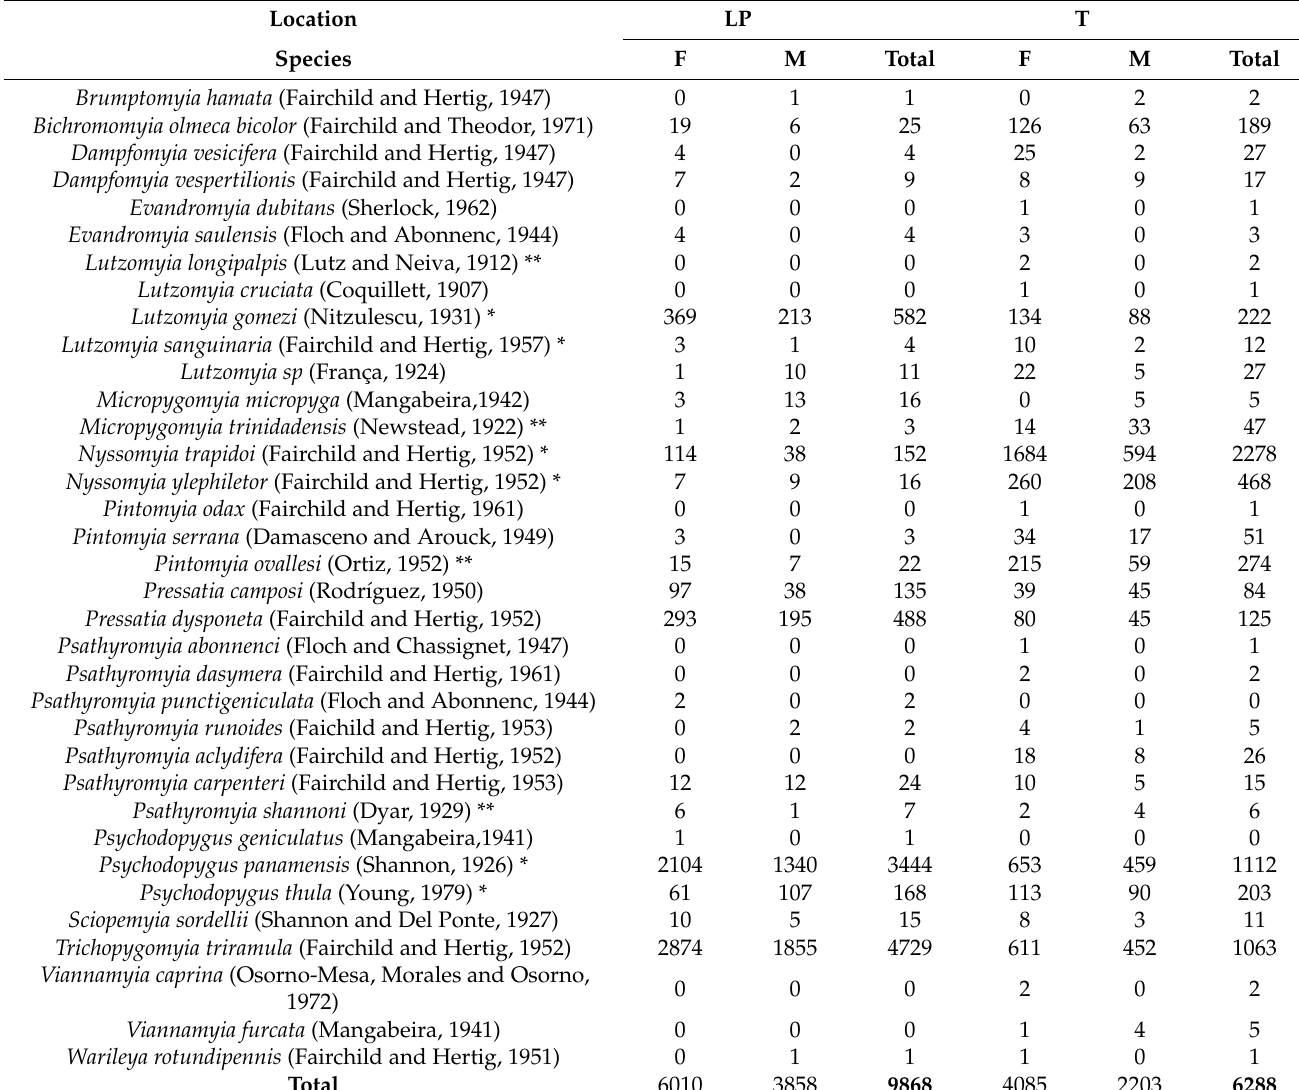
Table 1. Abundance and diversity of sand flies collected from 2013 to 2015 in Las Pavas (LP) and Trinidad de las Minas (T), Western Panam á